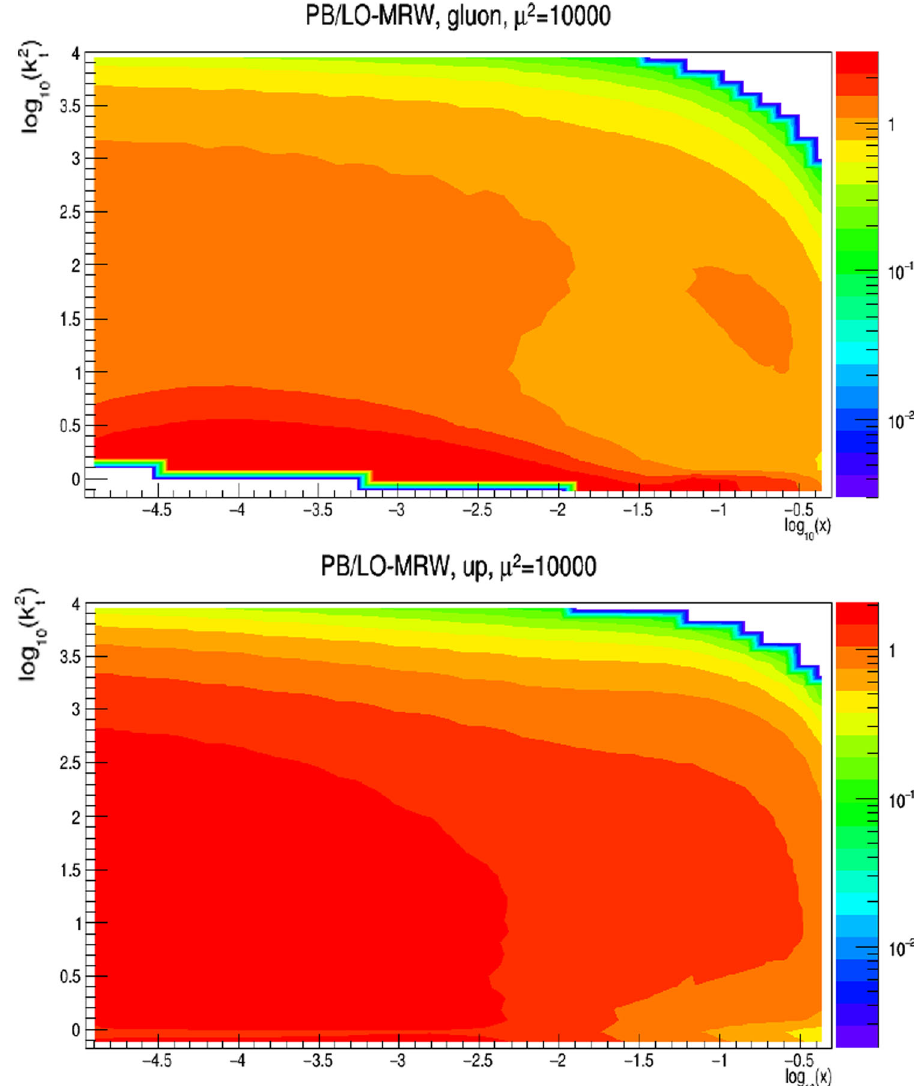
Fig. 5 The top (bottom) panel shows the fraction of PB / LO − MRW for gluon (up) quark at μ 2 = 10000, respectively